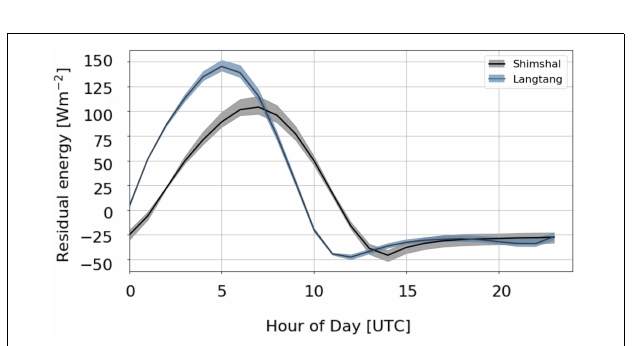
FIGURE 9 | Diurnal cycle of the residual flux for Shimshal (black) and Langtang (blue). The shading indicates the interannual variability.